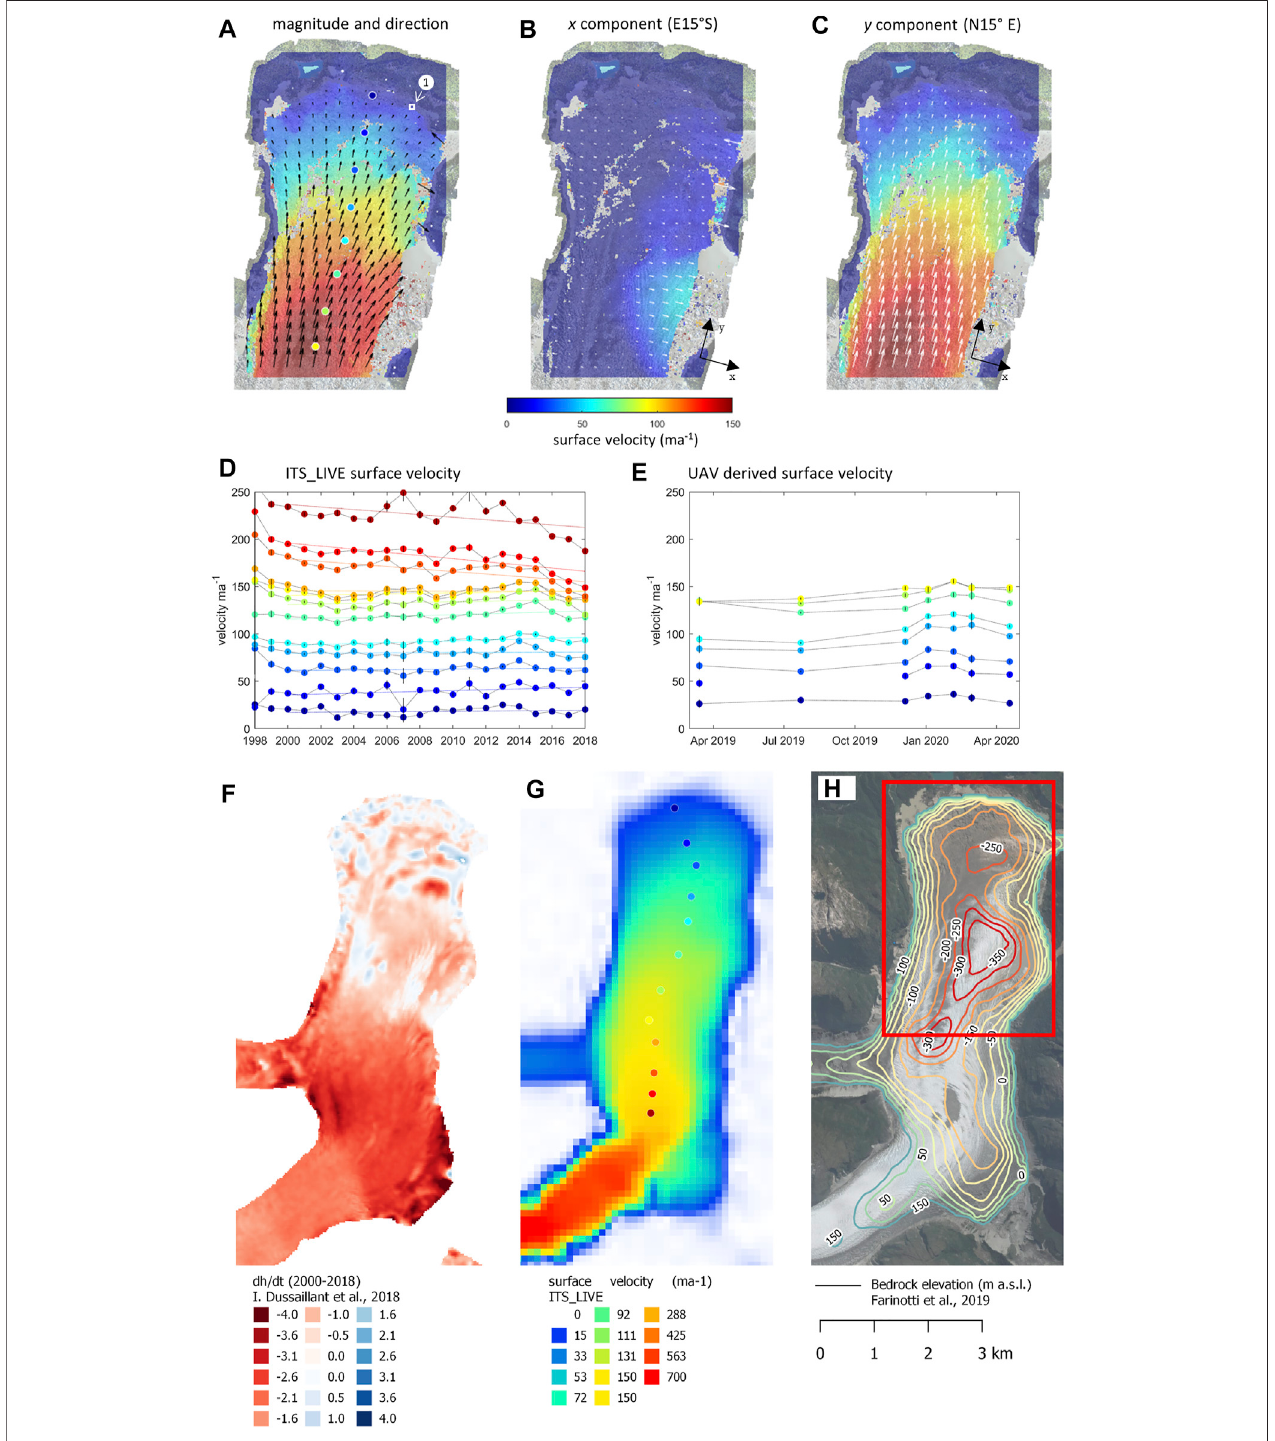
FIGURE4|(A – C) UAV derived surfacevelocityfrom surveys fromMarch 2020toMay 2020.Note that thearrows size isrelatively scaled foreach plot. (A) Surface velocity magnitude and direction. The color dots correspond to locations points in plots (D – E) and white square indicated with (1) show area of glacier advance. (B) Surface velocity x component. (C) Surface velocity y component. (D,E) Surface velocity (ordinates) at different locations and date (abscises). (F) Thinning rates dh/dt (m a − 1 ) from dates 2000 – 2018 (Dussaillant et al., 2019b). (G) Ice surface velocity (m a − 1 ) ITS_LIVE (Gardner et al., 2019). (H) Bedrock elevation model (Farinotti et al., 2019). Red square corresponds to the extent of plots (A – C) .